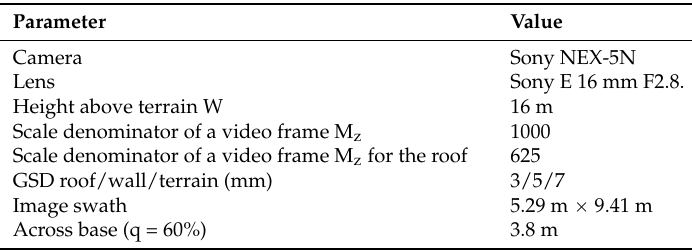
Table 5. Flight plan parameters.